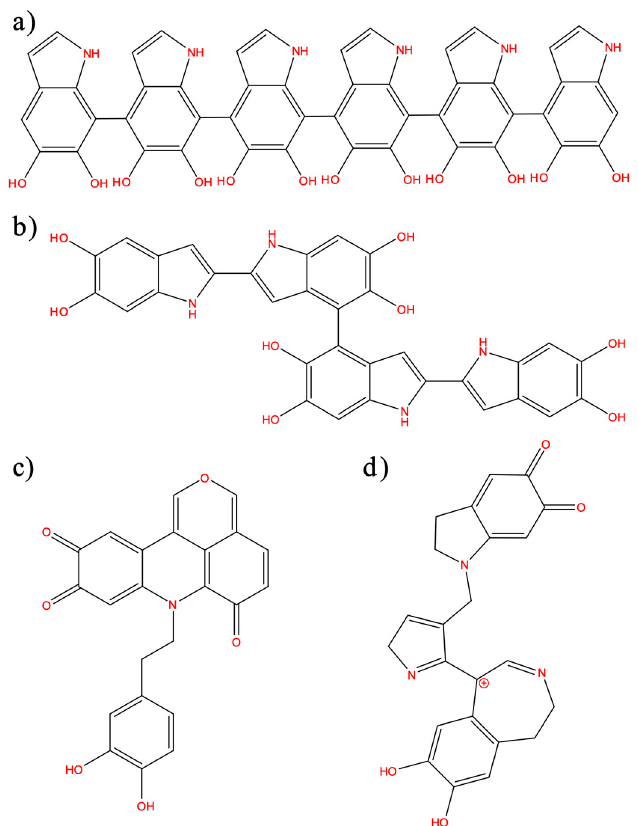
Figure 1. ( a ) Linear 5:6-dihydroxyindole (DHI)-based oligomers connected through 4,7 positions; ( b ) DHI-based oligomers with different combinations of connectivities at 2,4,7 positions; ( c ) oligomers based on a pyranoacridinotrione (PYR) motif; and ( d ) combination of a dopaminochrome unit, a 2H pyrrole moiety, and benzazepine (C 23 H 20 N 3 O 4+ , m / z 402).